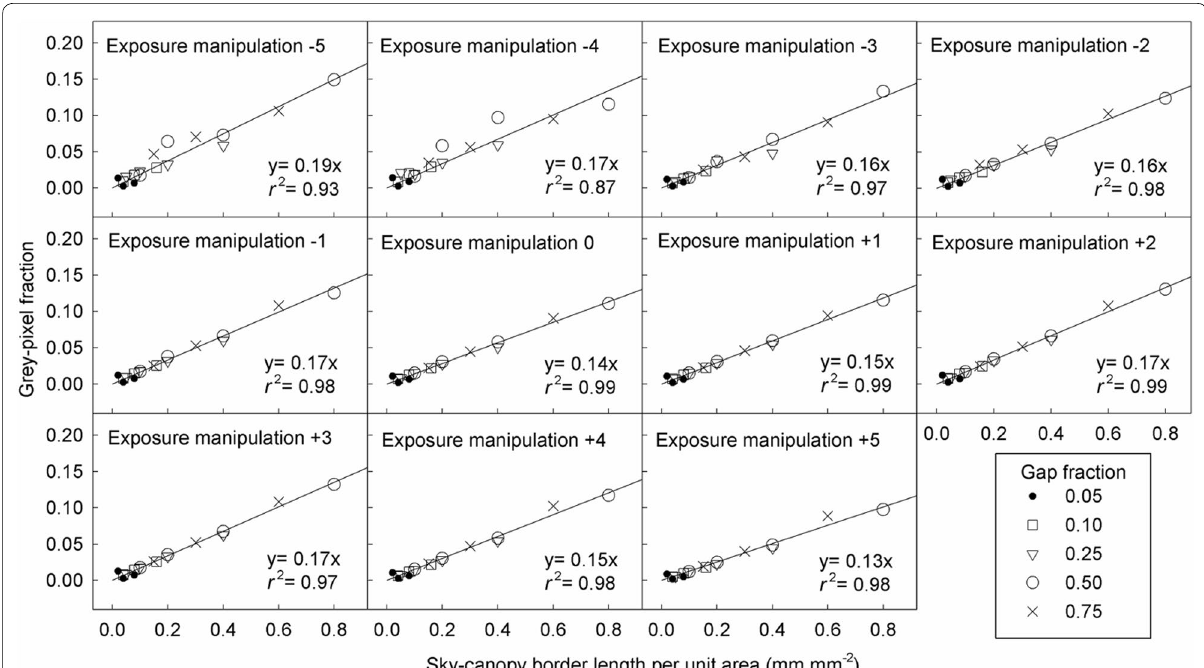
Fig. 4 Relationships between the grey‑pixel fraction and the SCB length of model canopies in model CHPs. The unit of the exposure manipulation is